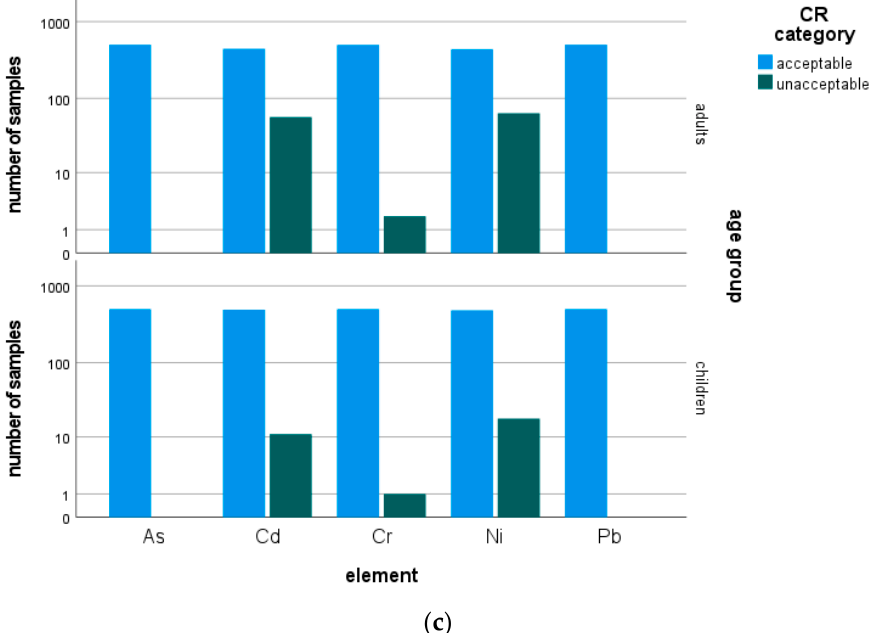
Figure 4. Summarised results for ( a ) HQ, ( b ) HI, and ( c ) CR. Table 8. HQ, HI and CR values in each